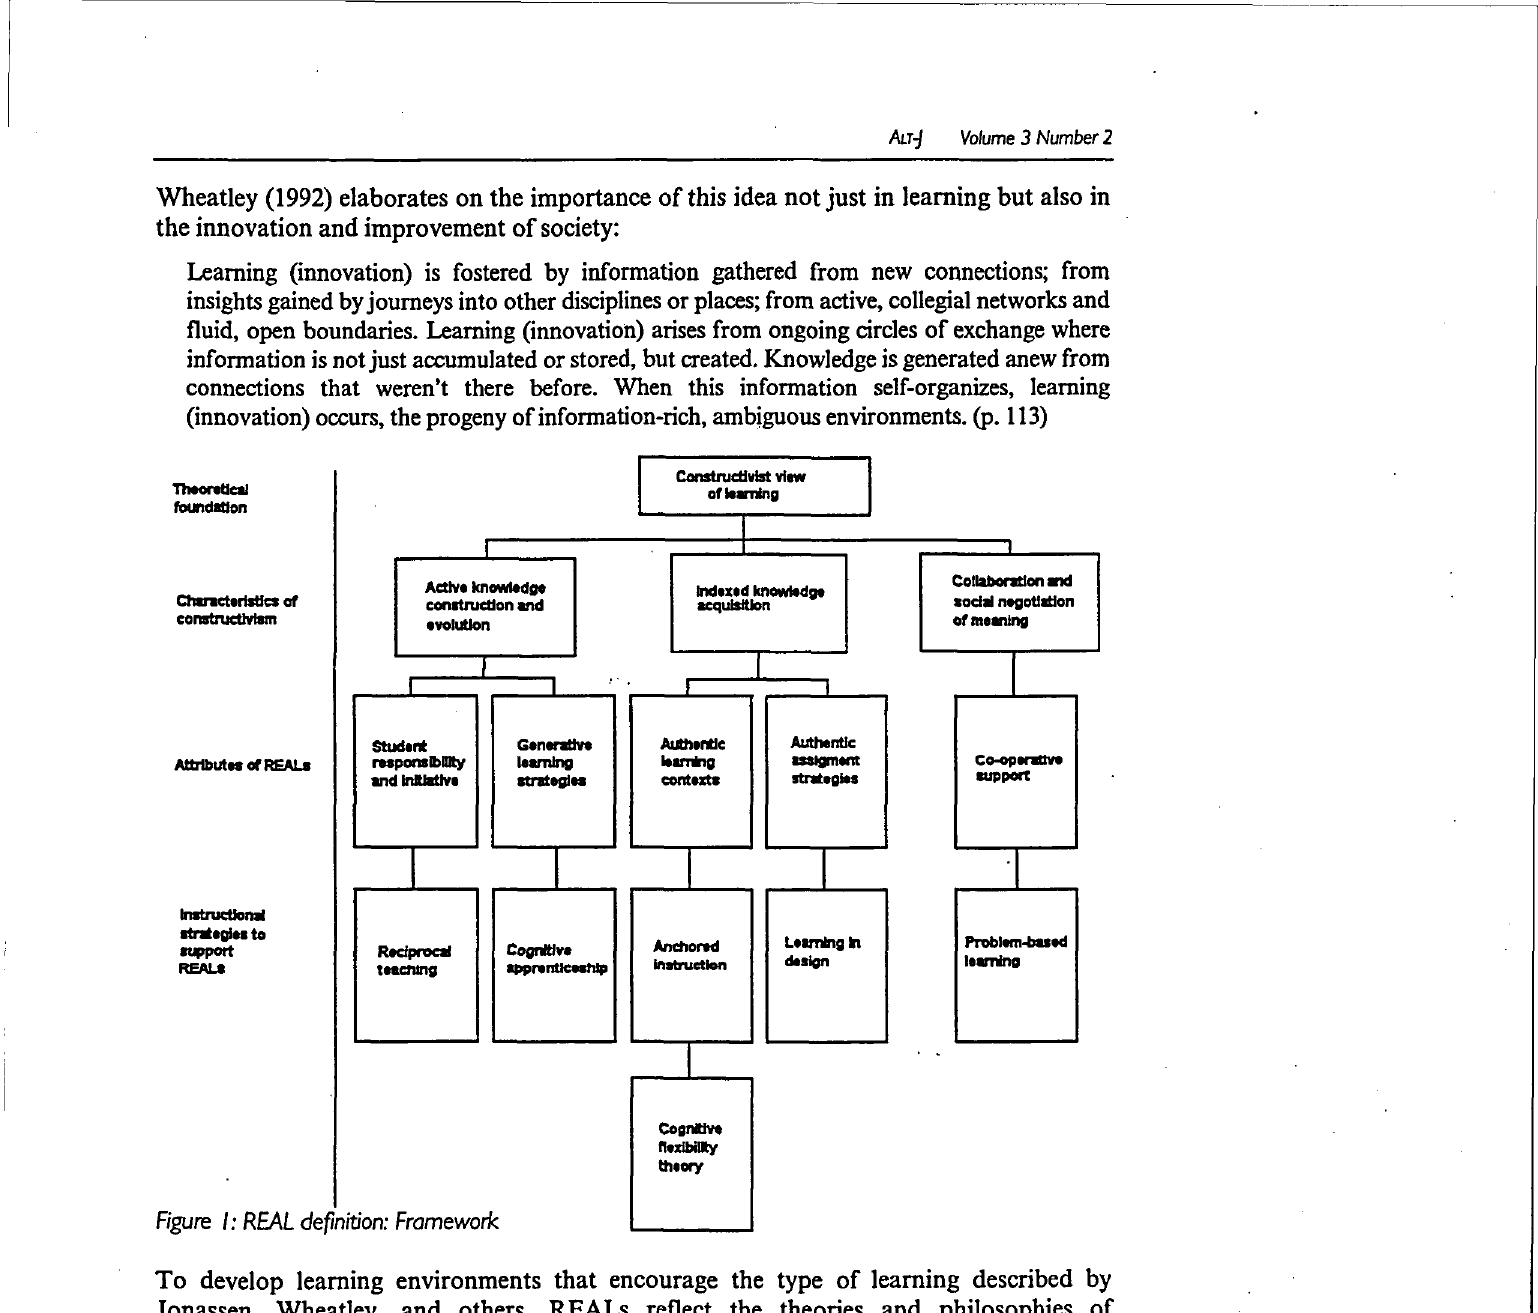
Figure I: REAL definition: